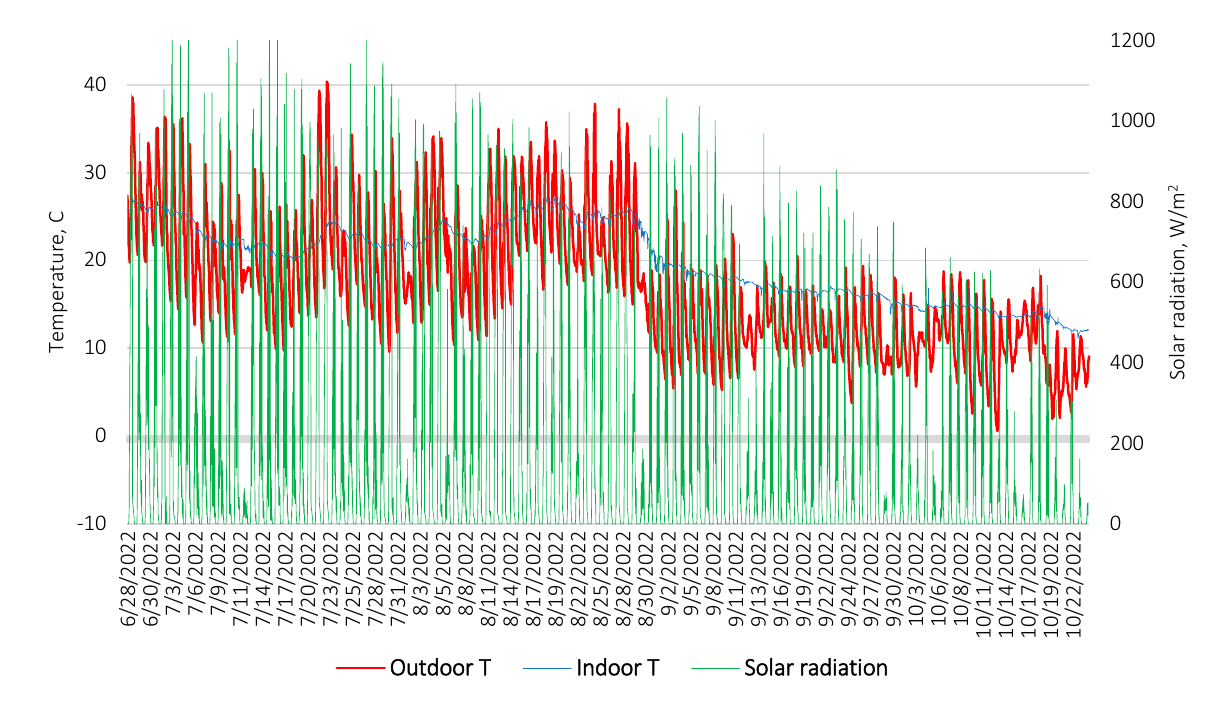
Figure 7. Incident solar radiation, outdoor and indoor temperature.